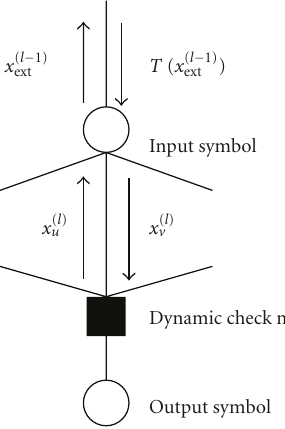
Figure 2: Notations used for the asymptotic analysis of a Raptor code with IC